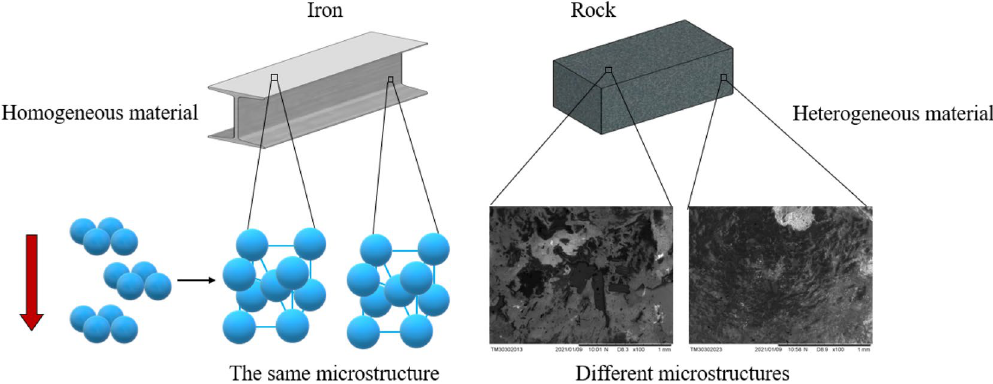
Figure 1. The microstructure of typical homogeneous material and heterogeneous material.